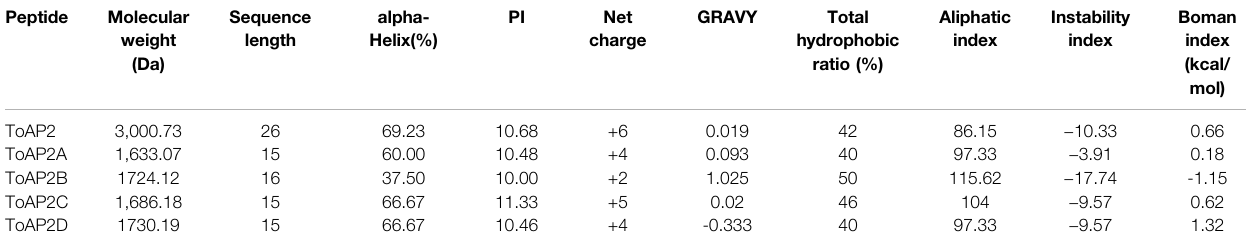
TABLE 2 | The comparison of physical and chemical properties of ToAP2 and its derived peptides. Peptide Molecular